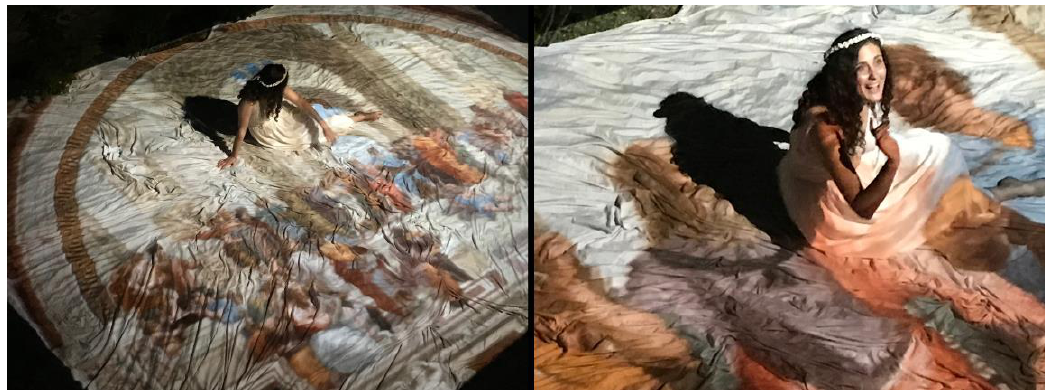
Figure 12. Site-specific installation dedicated to Raffaello Sanzio’s School of Athens . Realized by Teatro Potlach with CNR ITABC and presented in Invisible Cities, Fara in Sabina, 2019.